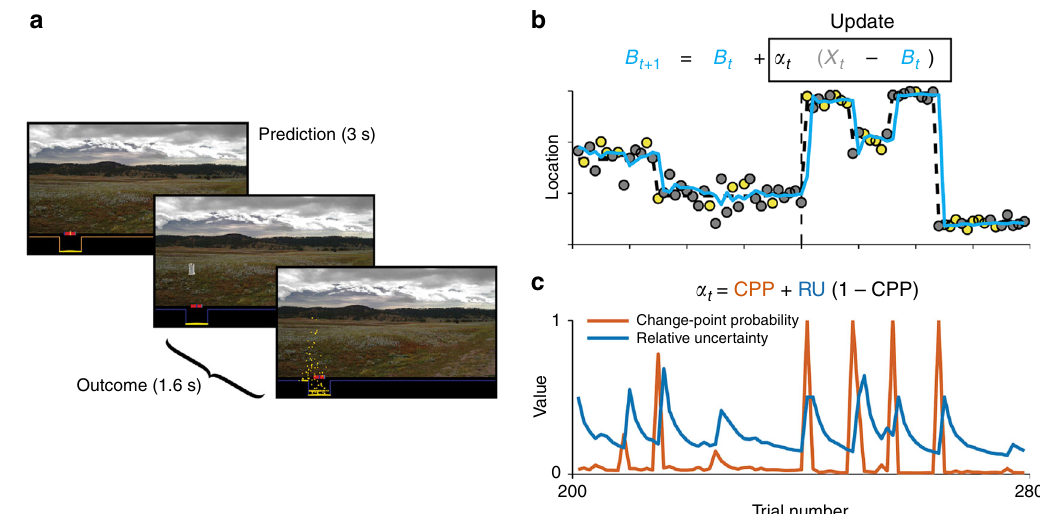
Fig. 1 Overview of the task and theoretical model of belief updating (McGuire et al., 2014). a Sequence of the task. At the start of each trial, participants predict where a bag will drop from an occluded helicopter by positioning a bucket on the screen. After participants submit their prediction, the bag drops and any rewarded coins that fall in the bucket are added to the participant ’ s score. The location of the last prediction and the last bag drop are noted on the next trial. b An example sequence of trials. Each data point represents the location of a bag on each trial (yellow for rewarded coins, gray for neutral coins). The dashed line represents the true generative mean. The mean changes occasionally. The cyan line represents the prediction from a normative model of belief updating. The inset equation shows how the model updates beliefs ( B t = belief, X t = observed outcome, α t = learning rate on trial t ). The vertical dashed line represents the boundary of the noise conditions: high-noise (left) and low-noise condition (right). Noise refers to the variance of the generative distribution. c Two learning components from the normative model. Change-point probability (CPP) re fl ects the likelihood that a change-point happens, which is increased when there is an unexpectedly large prediction error. Relative uncertainty (RU) re fl ects the uncertainty about the generative mean relative to the environmental noise, which is increased after high CPP trials and decays slowly as more precise estimates of the generative mean are possible. The inset formula shows how CPP and RU contribute to single trial estimates of learning